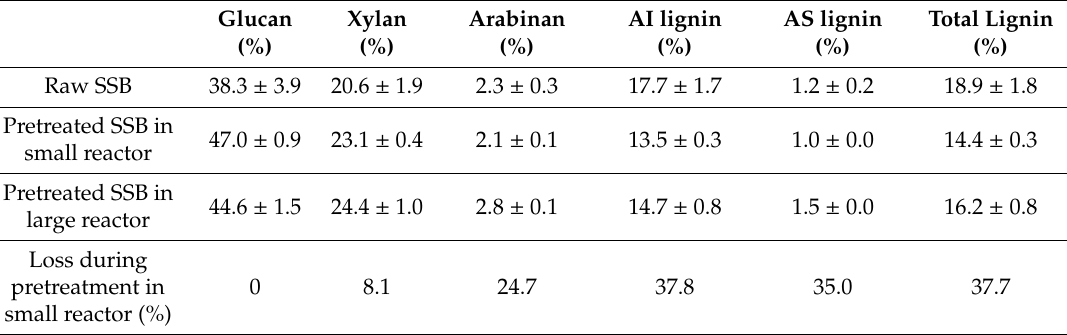
Table 2. Compositions and mass balance of SSB pretreated with Na 2 CO 3 solutions obtained by absorption of the CO 2 produced in SSJ fermentation in 5 M NaOH.